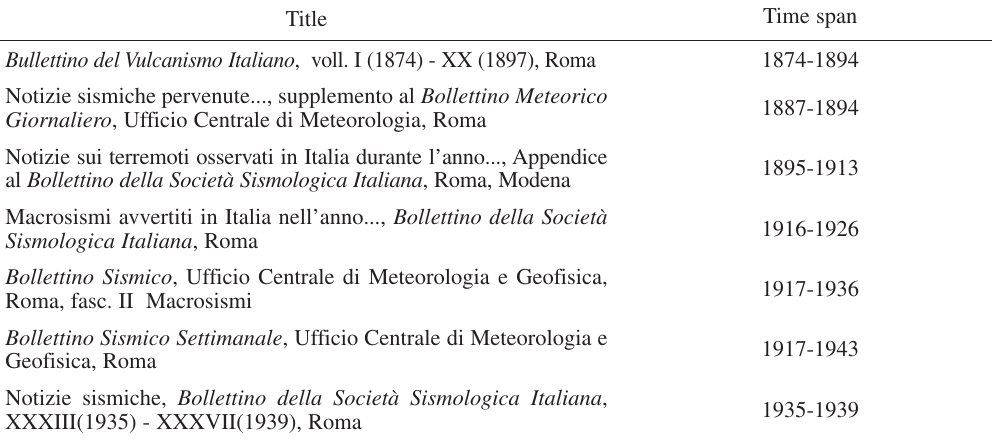
Table II. Main seismological bulletins published in Italy from 1874 to